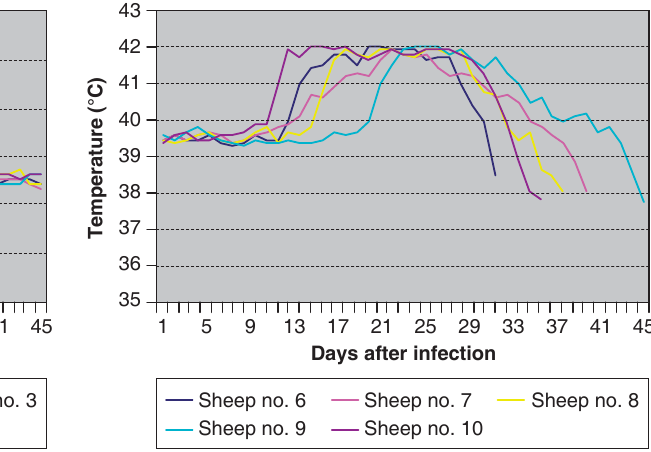
FIG. 3 Thermal reactions in the five lambs in Group B